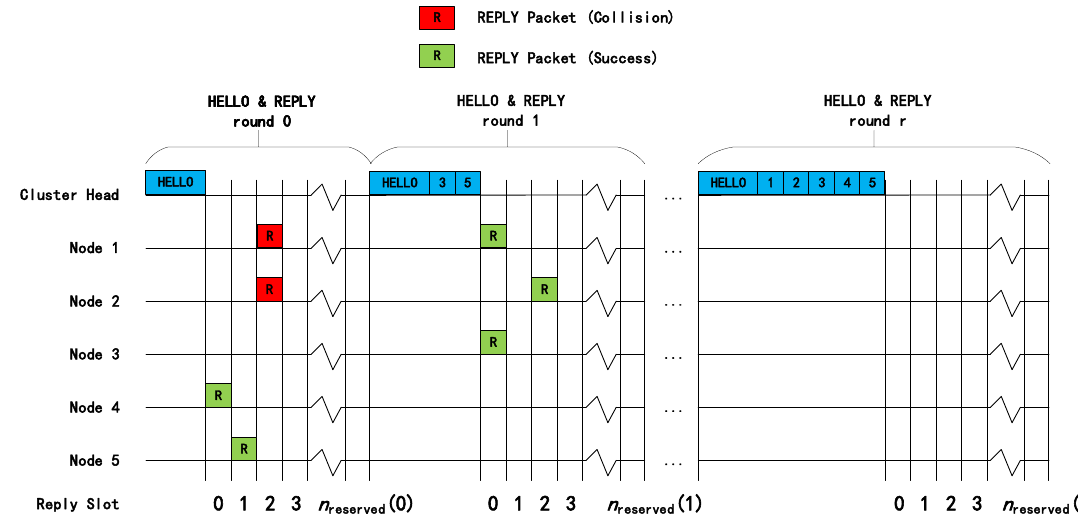
Figure 9. Neighbor discovery with random reply mechanism ( N =